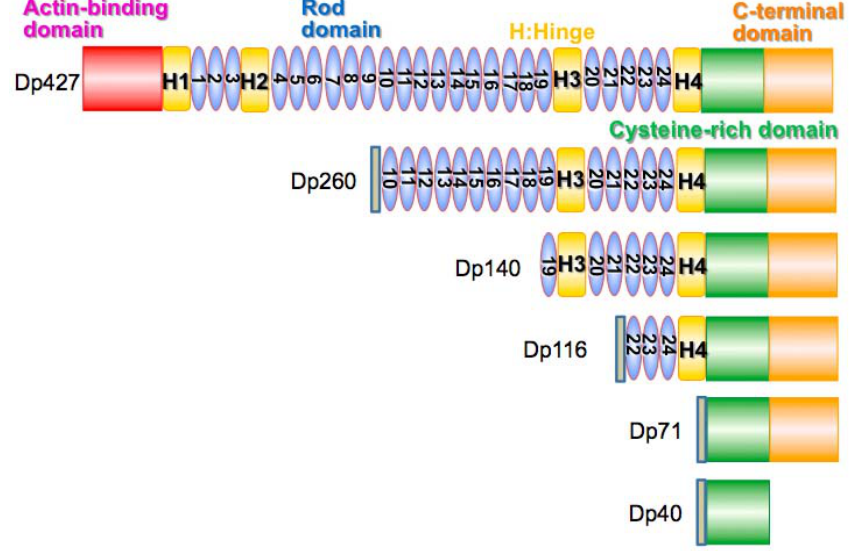
Figure 8. DMD/dystrophin protein (Dp) isoforms. The DMD ( dystrophin) gene